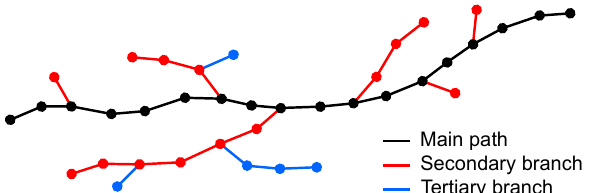
Figure 12. Fictitious crack EG with identified main crack path (black) and lateral branches (red and blue). The latter can also be classified by length or by the connection hierarchy as depicted in the figure.